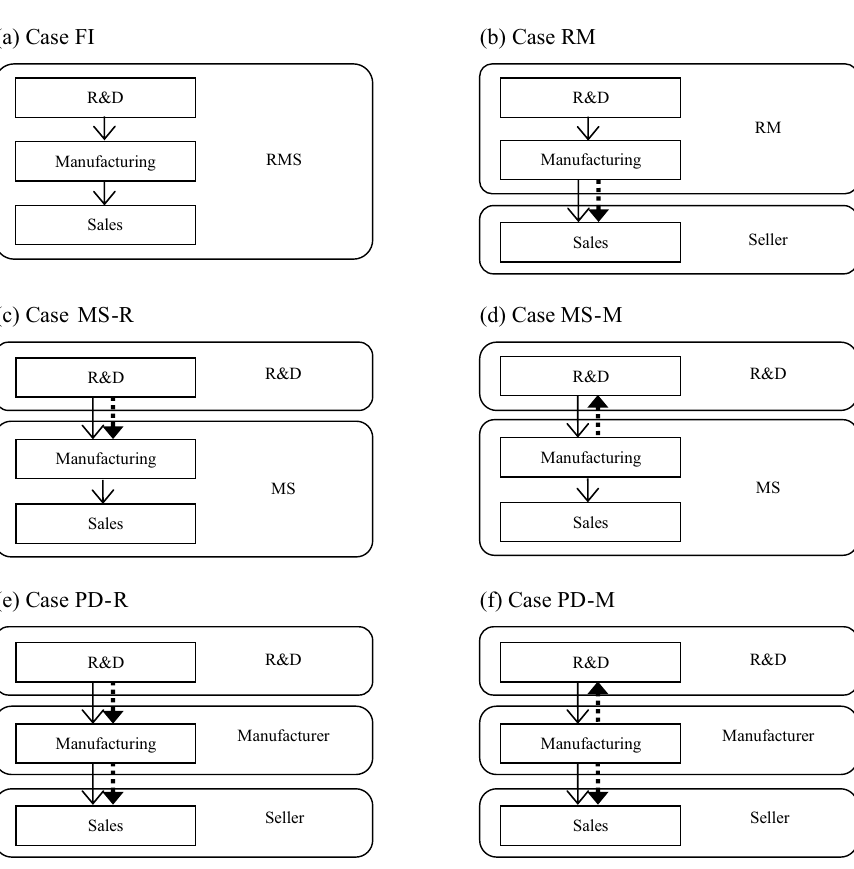
Fig. 1. Supply chain models (R: R&D, M: manufacturer, S: seller; solid